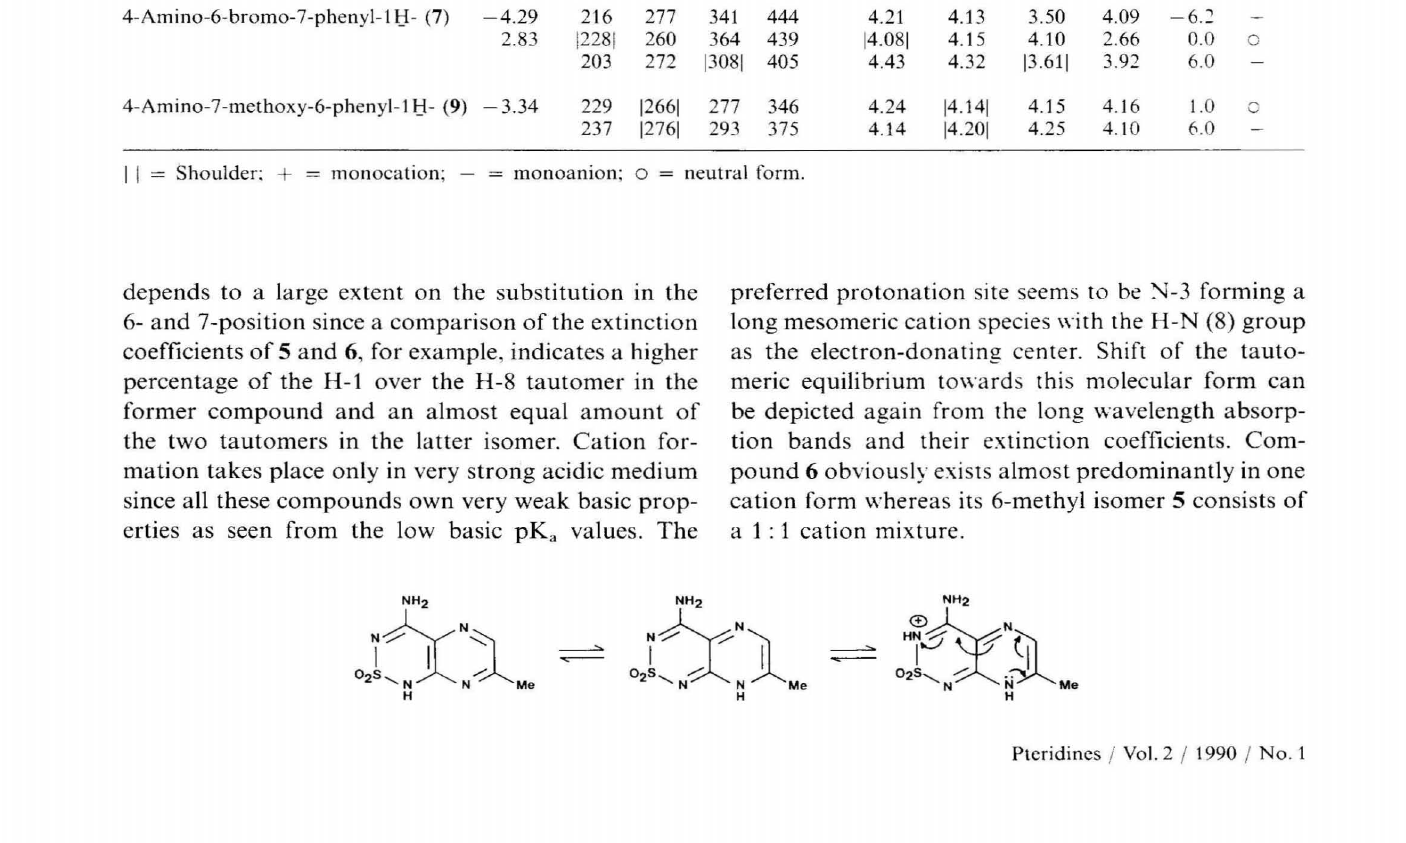
4-Amino-6-methyl-81j-